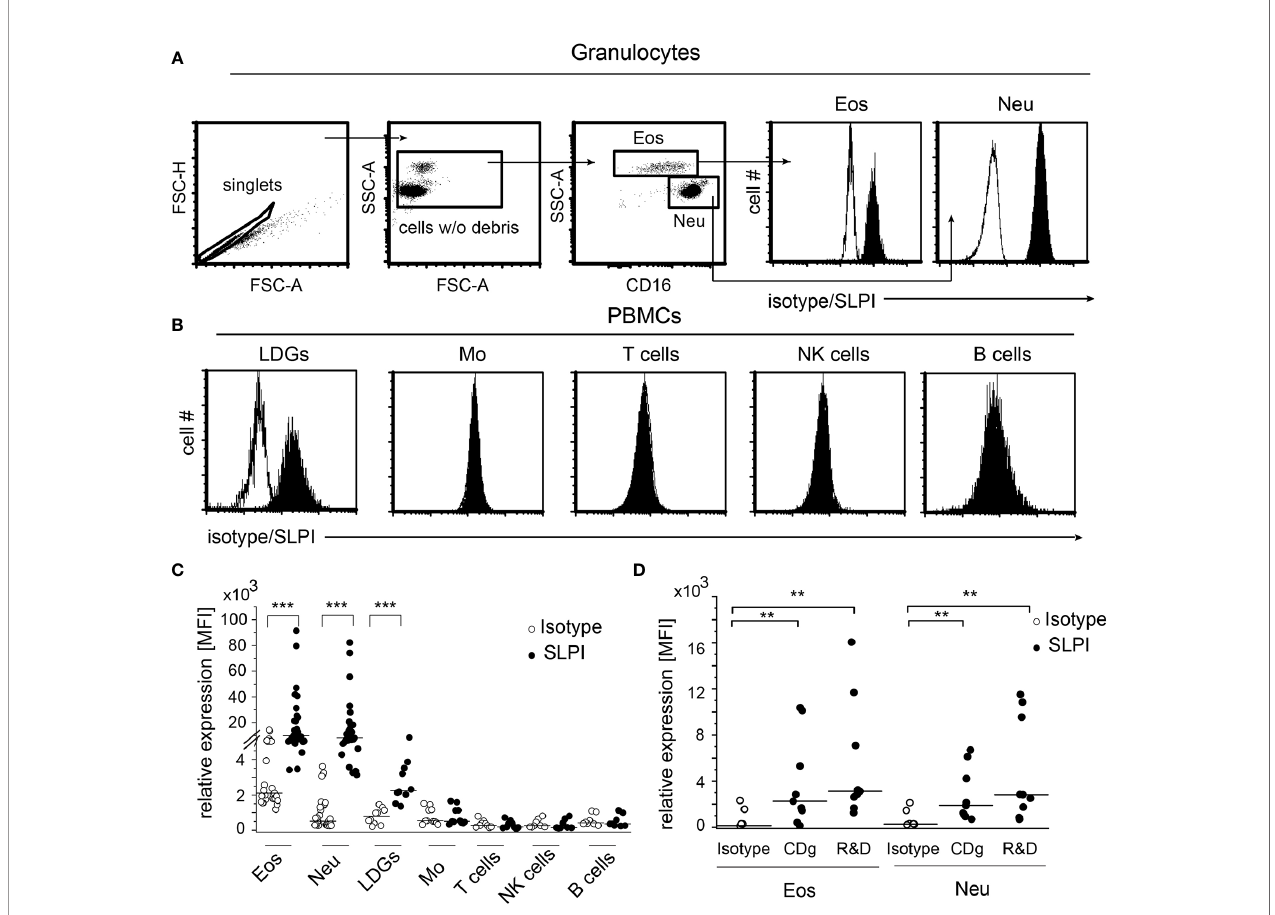
FIGURE 1 | Granulocytes, including eosinophils, are the main source of SLPI among circulating leukocytes in healthy individuals. Granulocytes (A) and PBMCs (B) from healthy donors were subjected to fl ow cytometry analysis for SLPI expression using anti-SLPI mAbs (clone: 31, Abcam) (shaded histograms) or isotype control (empty histograms). Eosinophils (Eos) and neutrophils (Neu) were identi fi ed in granulocyte fraction on the basis of the gating strategy indicated (dot plots, A ), whereas LDGs, monocytes (Mo), NK cells, T cells, and B cells in the PBMC fraction were identi fi ed on the basis of gating on singlets, cell w/o debris, and staining for CD14, CD3, CD15, CD19, CD56, and/or CD16. Representative histograms for these cells are shown in (A, B) Data from all donors are shown as mean fl uorescence intensity (MFI), (C) . Data from donors stained with alternative anti-SLPI mAbs [Creative Diagnostics (CDg) and R&D] or isotype control are shown for Eos and Neu as MFI (D) . Lines indicate the median value for each data set. n = 29 or n = 10 for granulocytes and PBMCs, respectively (C) or n = 8 (D) . **p < 0.01; ***p < 0.001; Mann – Whitney